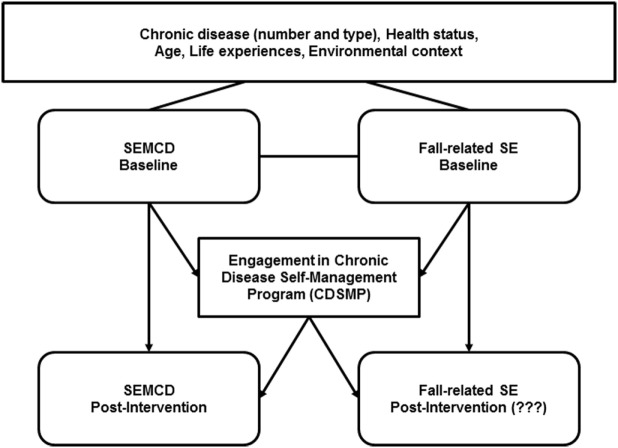
CDSMP and types of self-efficacy. Visual depiction of self-efficacy to manage chronic condition (SEMCD), Fall-related self-efficacy (Fall-related SE) and participation in Stanford’s Chronic Disease Self-Management Program (CDSMP). Arrows represent potential influences in self-efficacy (SE) at baseline and post-intervention (participation in CDSMP).